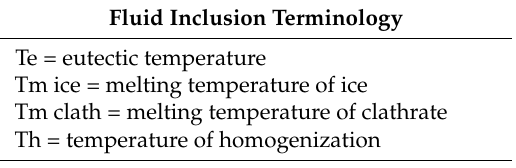
Table 3. Fluid inclusion terminology and types.